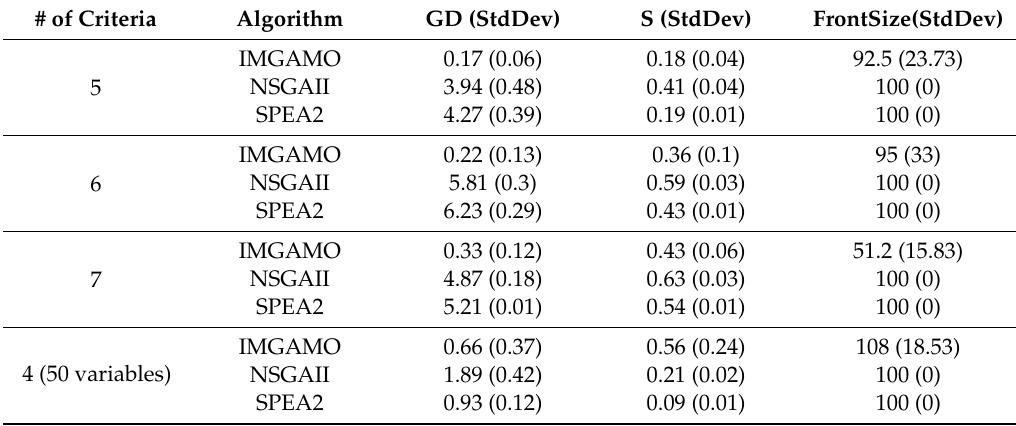
Table A4. Comparison of results for DTLZ2 problem.